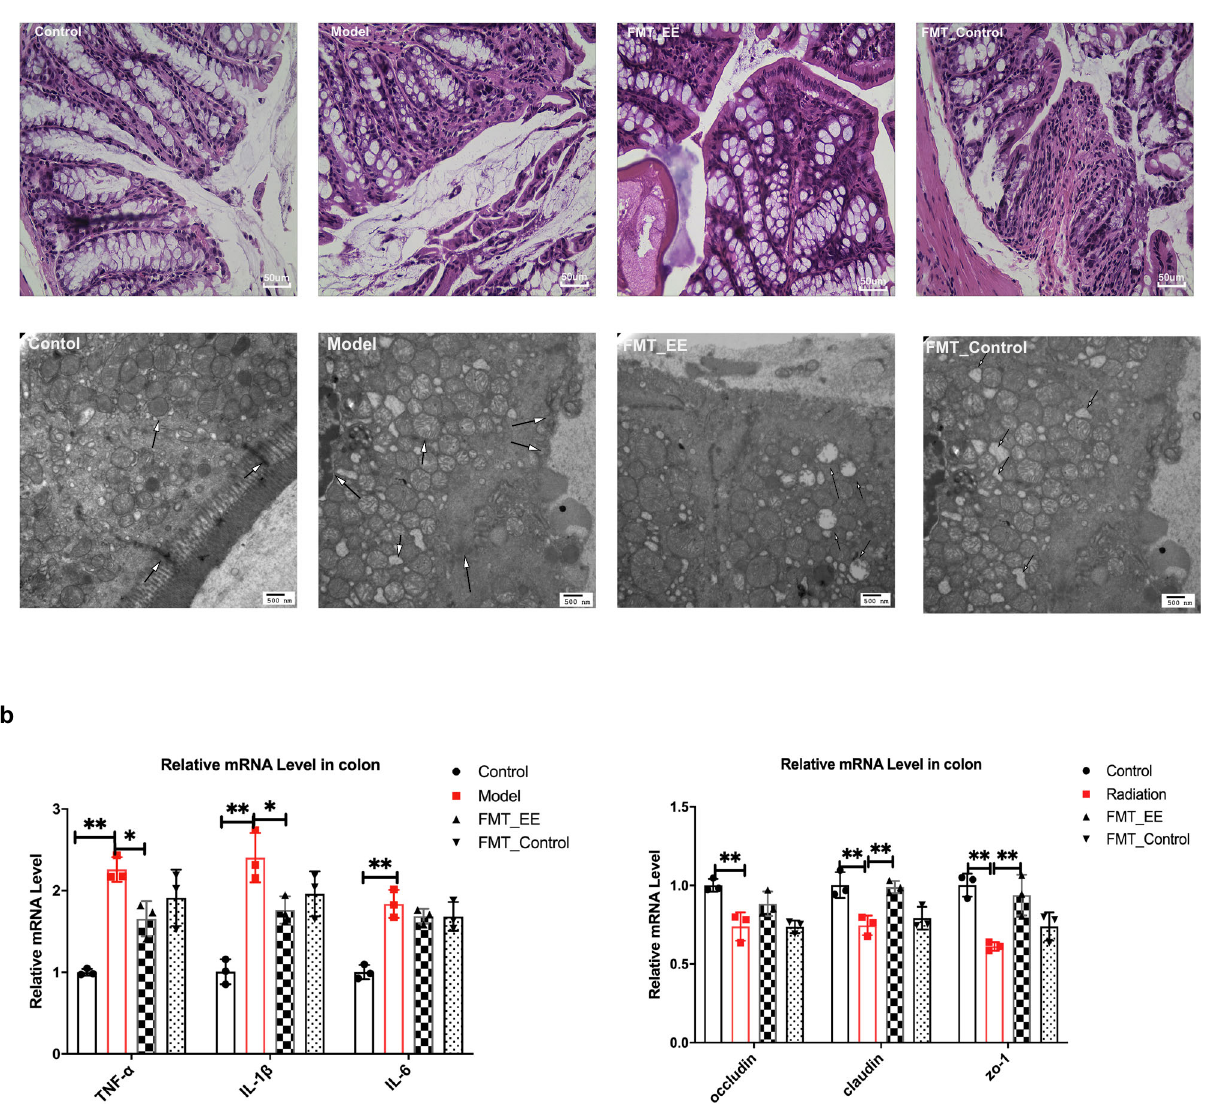
Fig. 7 FMT from EE-fed mice prevented colonic mucosa barrier impairment and in fl ammation in irradiated mice. a Histological features in colon. (H&E, scale bar = 50 μ m, TEM, scale bar = 500 nm). b The mRNA expression of in fl ammatory cytokines and tight junction proteins in colon of mice. Values are expressed as the mean±SD ( n = 5). Statistical analyses were conducted using the one-way ANOVA followed by Tukey ’ s post hoc test, * p < 0.05, ** p <